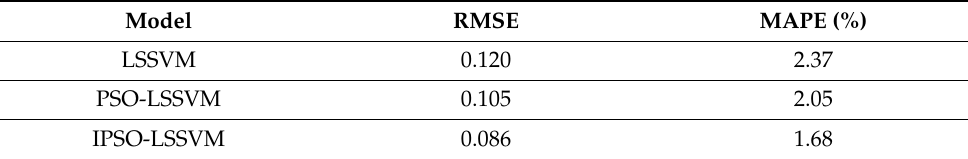
Table 7. Comparison of the evaluation results of different algorithms. Model RMSE MAPE (%)